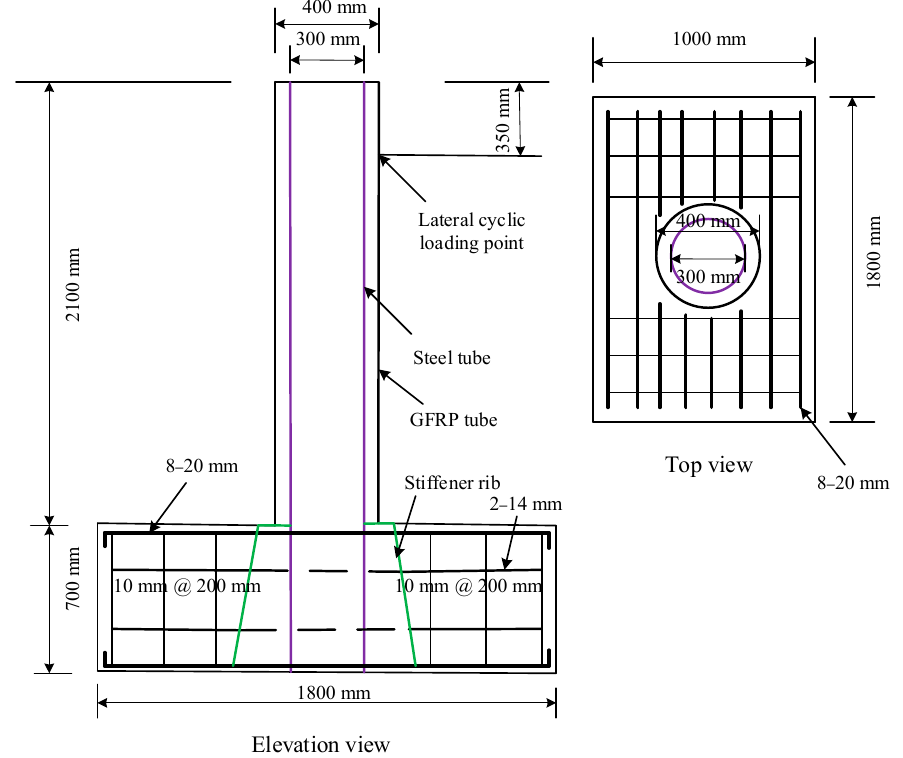
Figure 2. Elevation and plan views of FGSTC specimens. The three parameters studied were the axial load ratio (0.4 and 0.2), the percentage of recycled aggregates (r = 0 percent, 50%, and 100%), and the reinforcing ratio of composite specimens (3.04 percent and 3.81 percent). The volumetric quantity of coarse aggregates was used to substitute them. In this work, the axial load ratio was defined as the ratio of axial force to crushing load. The reinforcing ratio was calculated as the ratio of the